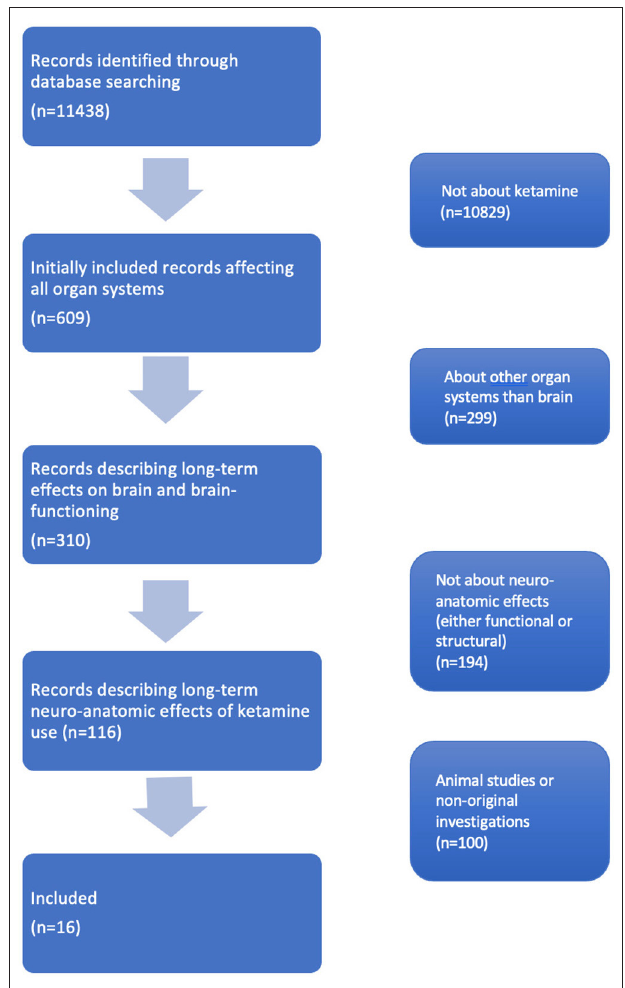
FIGURE 1 | Inclusion